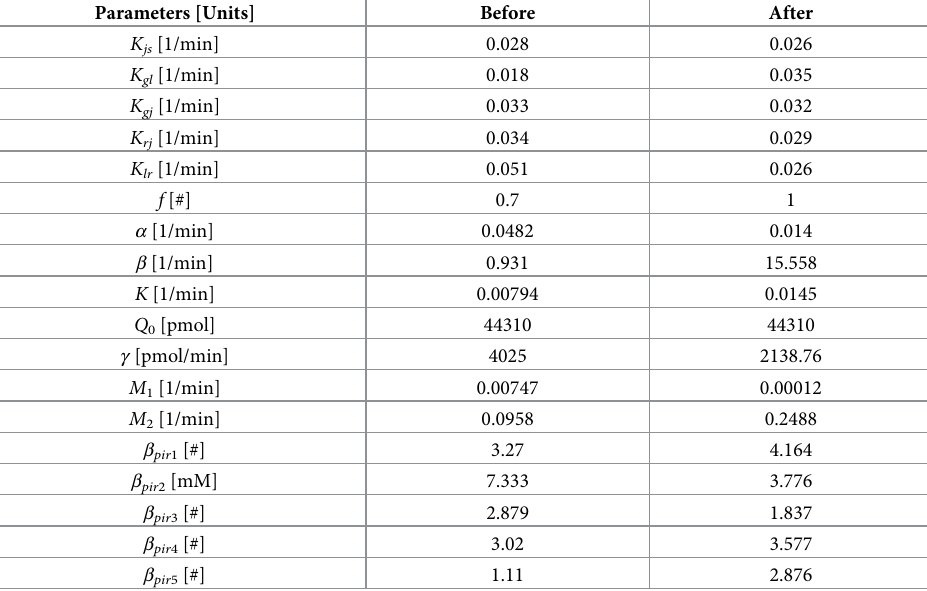
Table 3. STEP 3 results. Sorensen pancreatic insulin release model parameters before and after the optimization process. Parameters [Units] Before